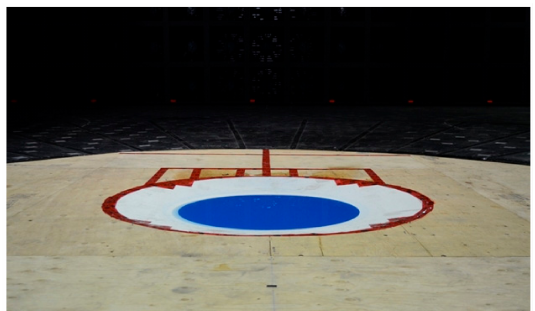
Figure 4. Water tank installed flush with chamber floor in WindEEE testing dome.